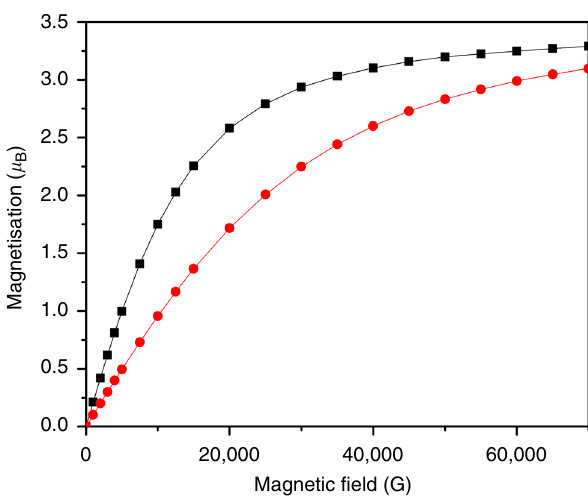
Fig. 4 Static temperature SQUID magnetometric data of powdered 3 in the solid state. Molar magnetisation as a function of applied magnetic fi eld at 4 (red dots) and 2 (black squares) K. Lines are a guide to the eye only